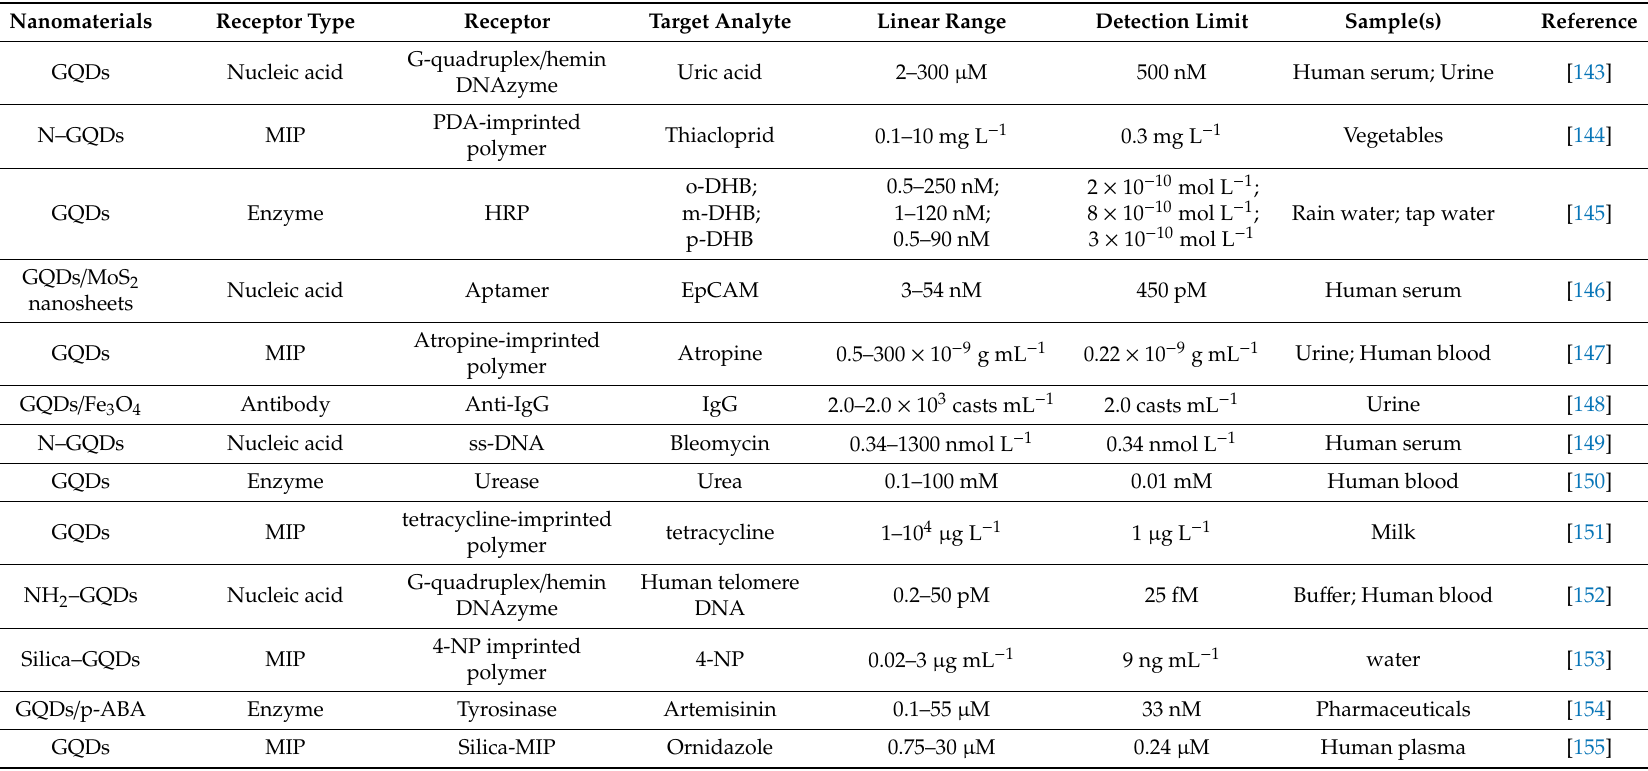
Table 2. Various GQD sensors based on fluorescence for biomedical applications developed over the last five